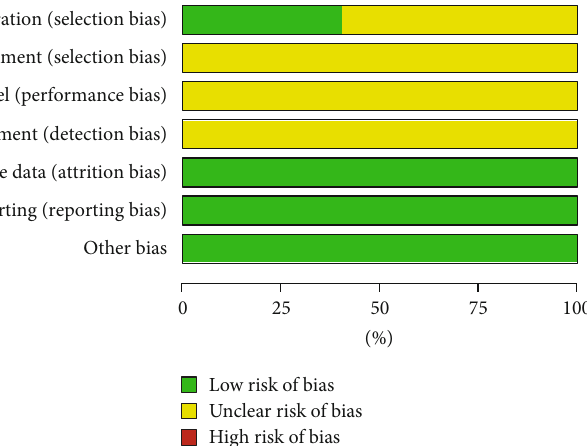
Figure 2: Risk of bias graph: review of authors ’ judgments regarding each risk of bias item presented as percentages across all included studies.